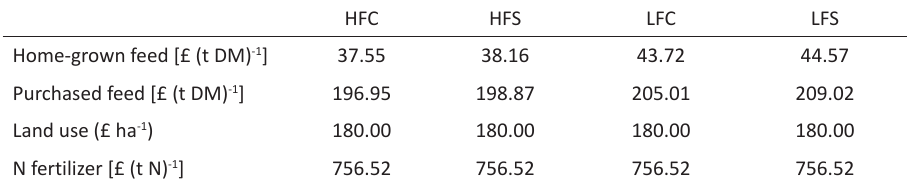
Table 1. Input price data for each system for the financial year April 2010–March